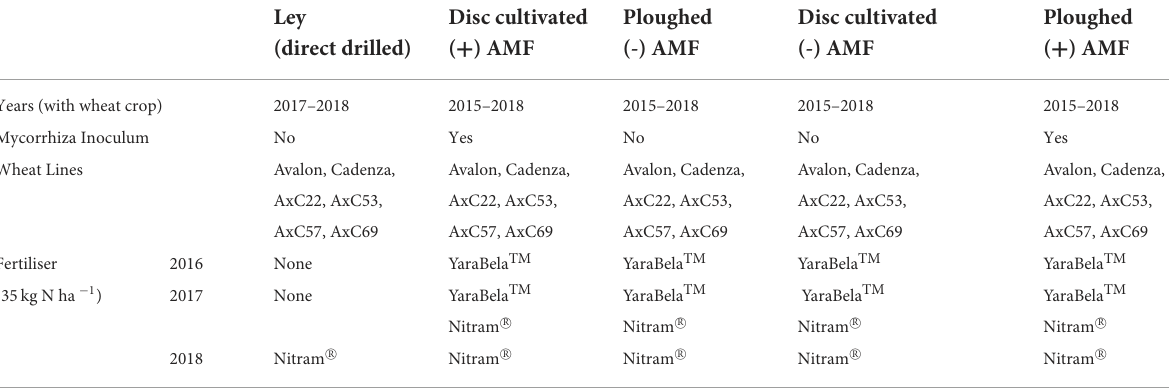
TABLE 1 Parameters and time periods for treatment application for the four-year field trial of winter